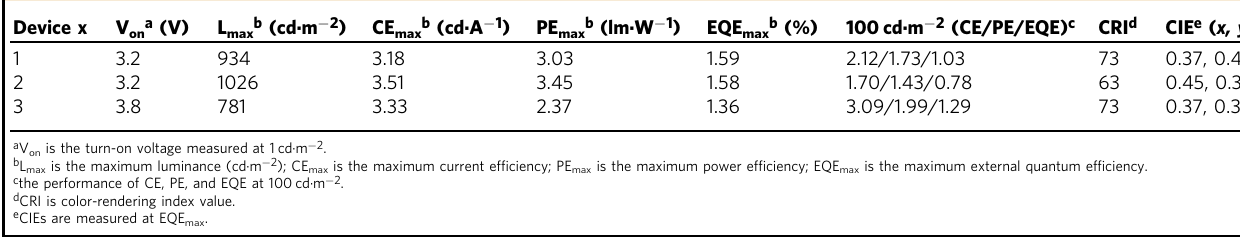
Table 1 EL Performances of OLEDs for BINAP